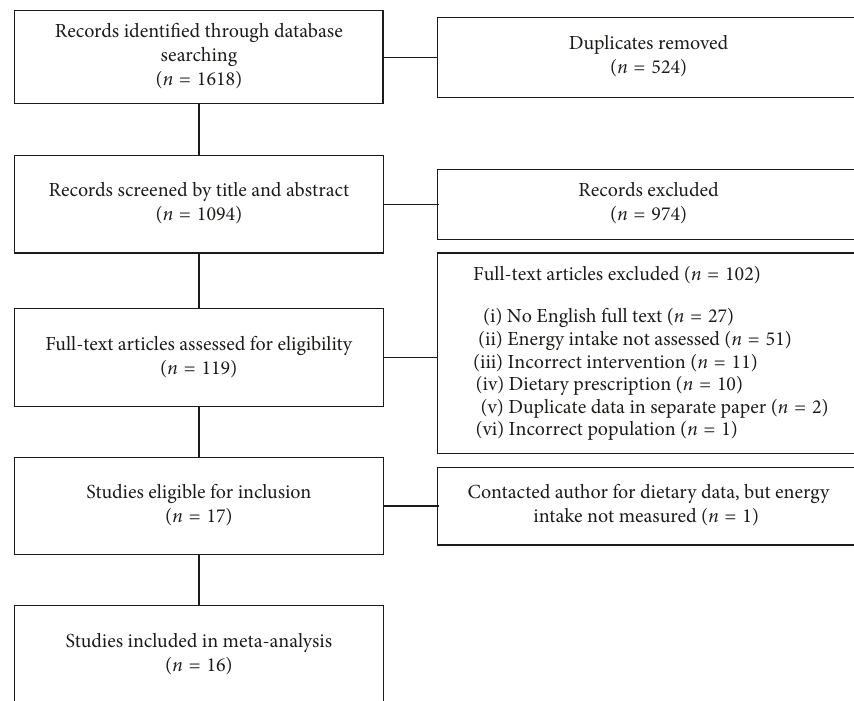
Figure 1: Flowchart of study